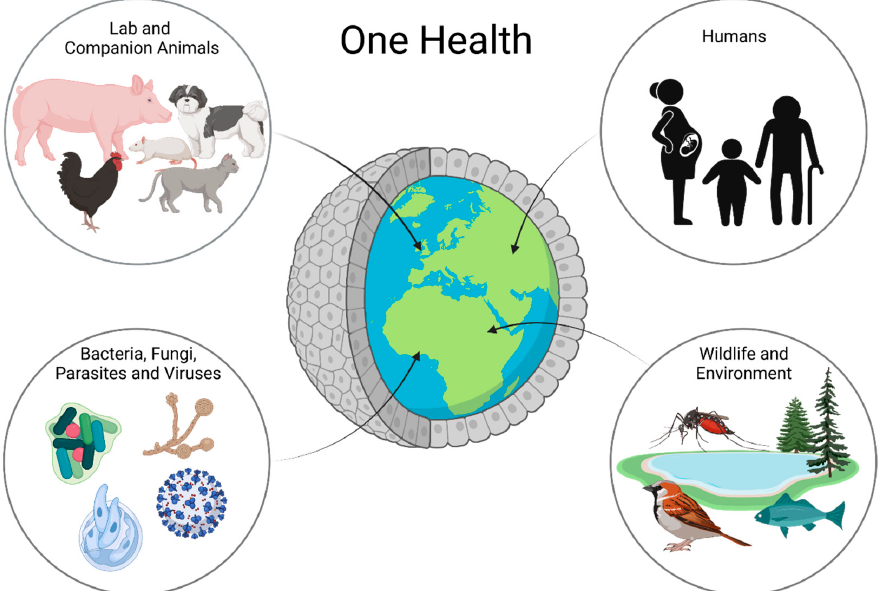
Figure 2. Organoids in One Health Research: Organoids are a possible way to work with all parts of One Health in one platform. Using organoids, one can learn about animal and human health and disease as well as interactions with the environment and bacteria, fungi, parasites, and even viruses.